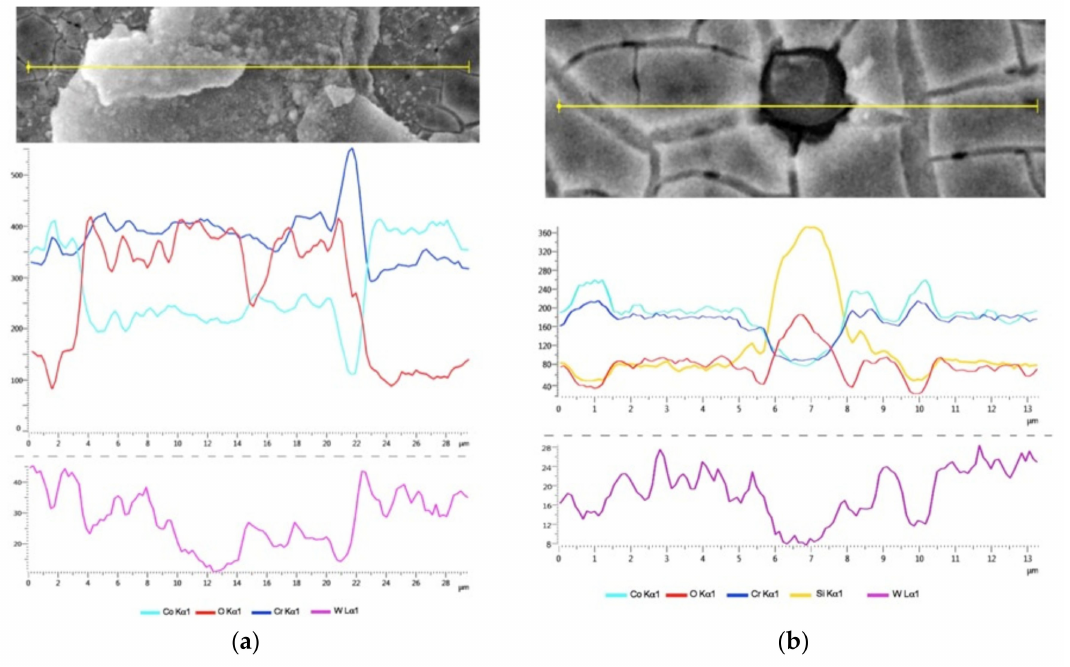
Figure 10. SEM-SE micrograph of CST1 with corresponding EDS line scan results: ( a ) along two oxide layers; ( b ) through the precipitation.